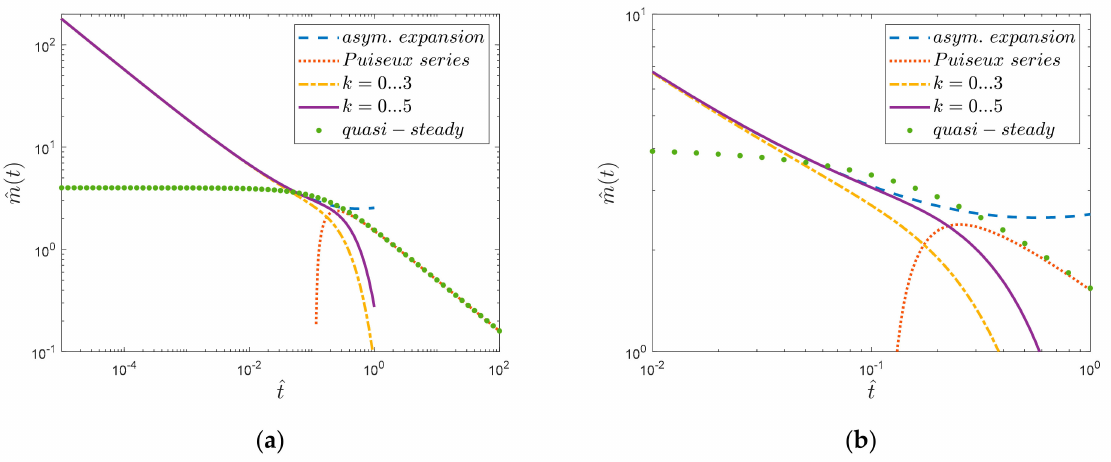
Figure 9. Comparison of novel solution received for initial power terms in time domain: ( a ) Extended range, ( b ) Enlarge.